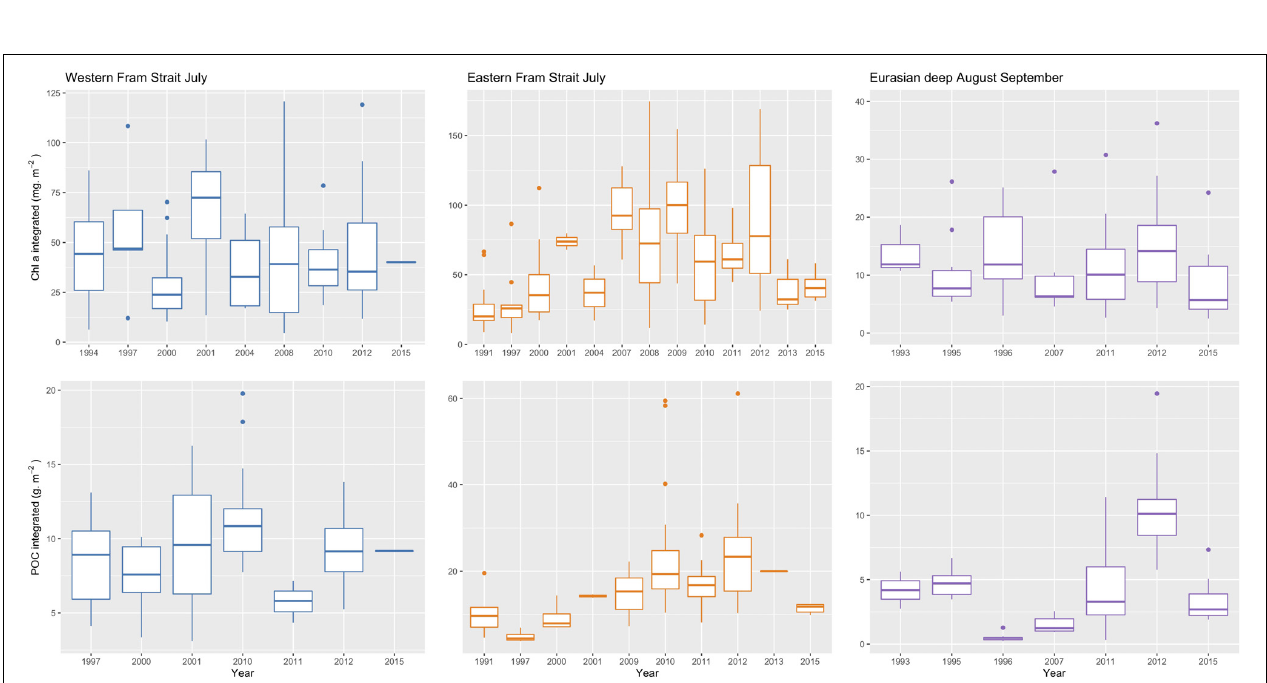
FIGURE 6 | Trends in upper: Chl a values (mg m − 2 ) and lower: POC values (g m − 2 ) integrated over 0–100 m water depth in the Fram Strait during July 1991–July 2015 and, the Eurasian Basin during August/September 1993–2015. Note the different scales.